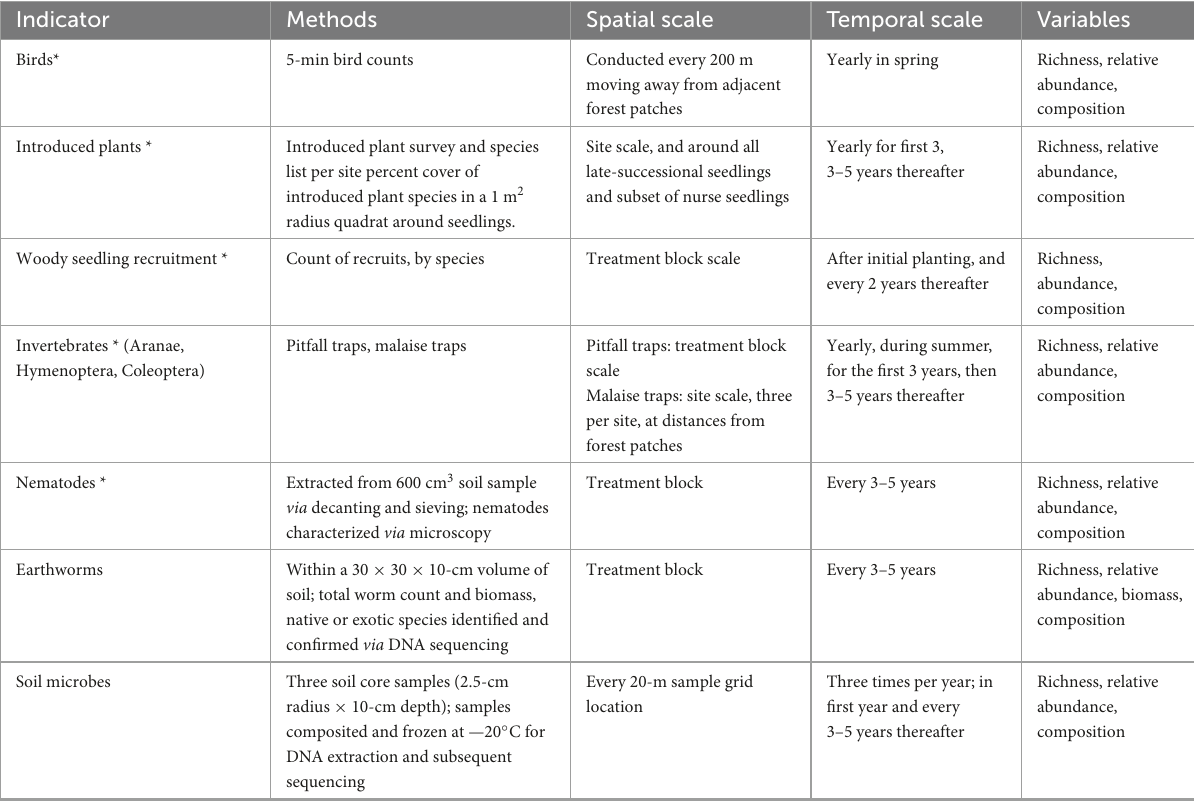
TABLE 3 Biodiversity indicator monitoring design and methodology for the AUT Living Laboratories program experimental